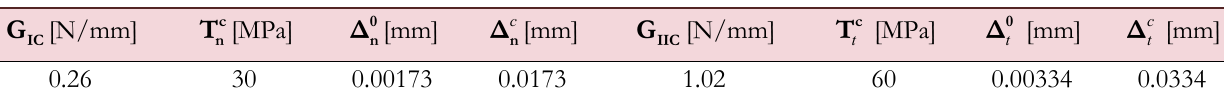
Table 2: Interface properties of the laminate.